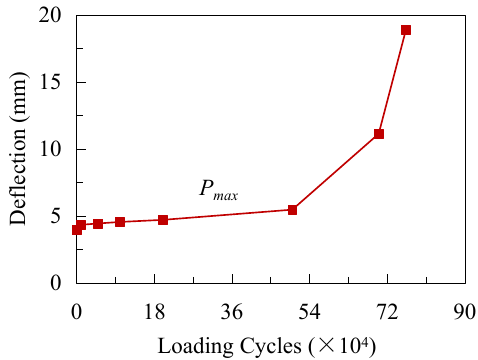
Figure 12. Deflection development under fatigue loading.